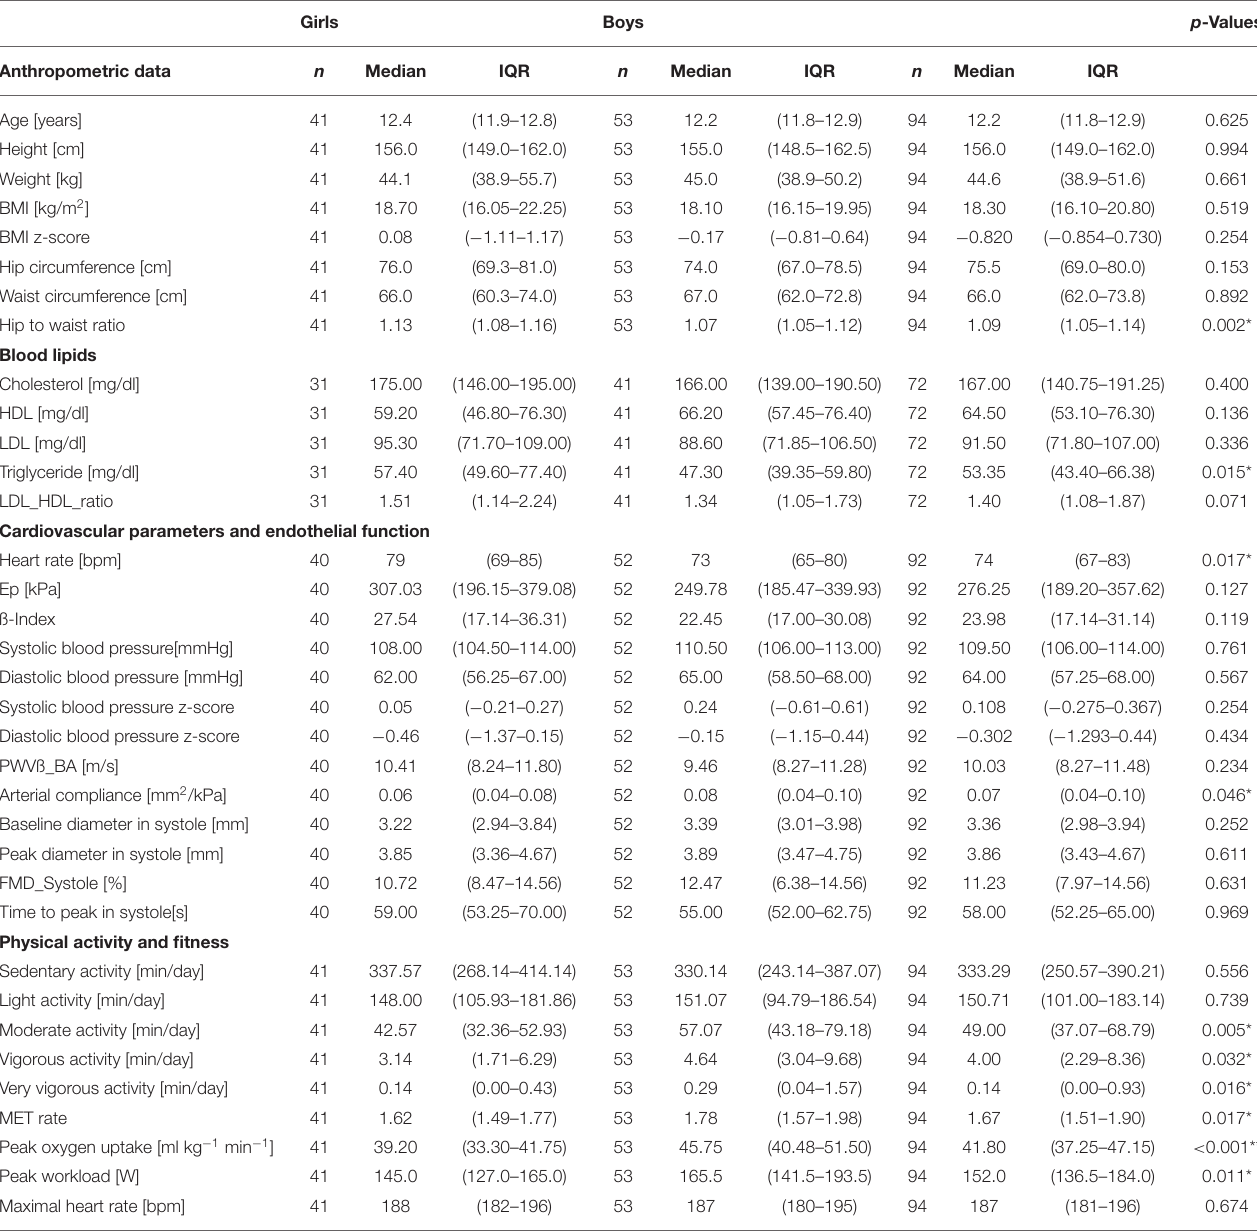
TABLE 1 | Characteristics of the study population.